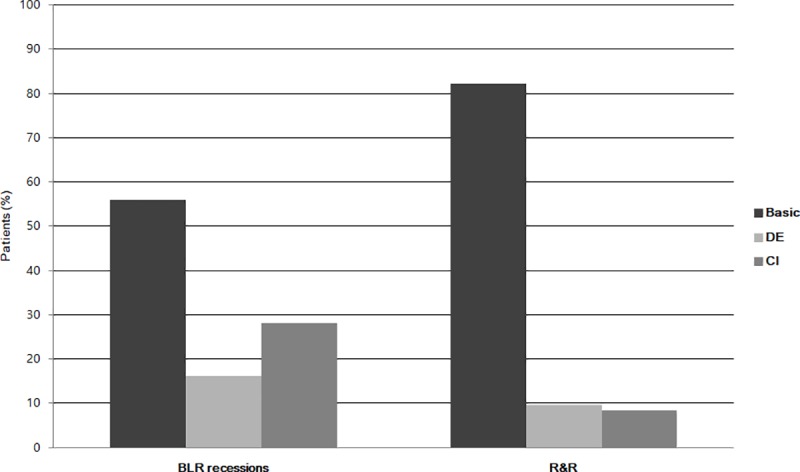
Bar graph showing the prevalence of the postoperative XT type between the BLR and R&R groups.The rate of postoperative CI-type XT in the BLR group (28.0%) was higher than that in the R&R group (8.4%) (p = 0.001). BLR = bilateral lateral rectus recession; R&R = unilateral rectus recession-resection; DE = divergence excess; CI = convergence insufficiency; XT = exotropia.